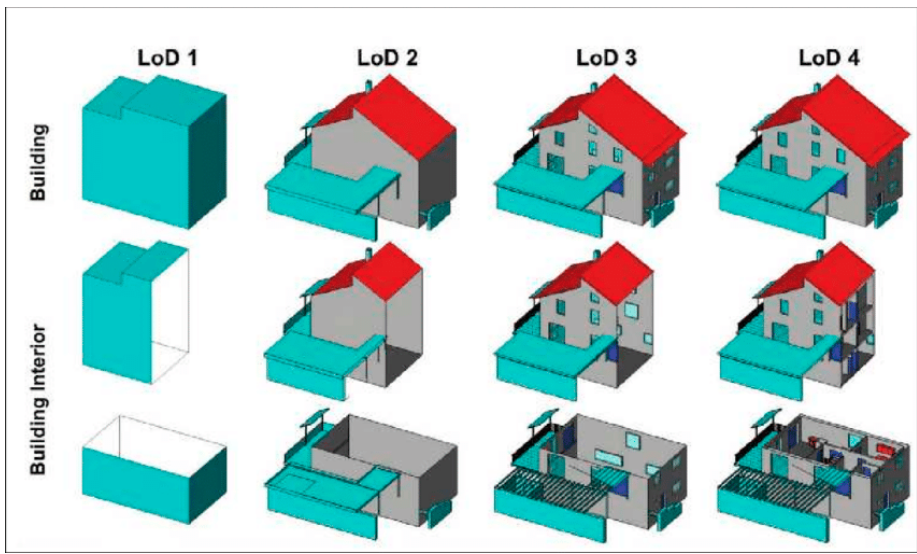
Figure 1. Different levels of details (LoD) represented in the CityGML standard (Source: Karlsruhe Institute of Technology (KIT), CityGML 2.0 Encoding standard).